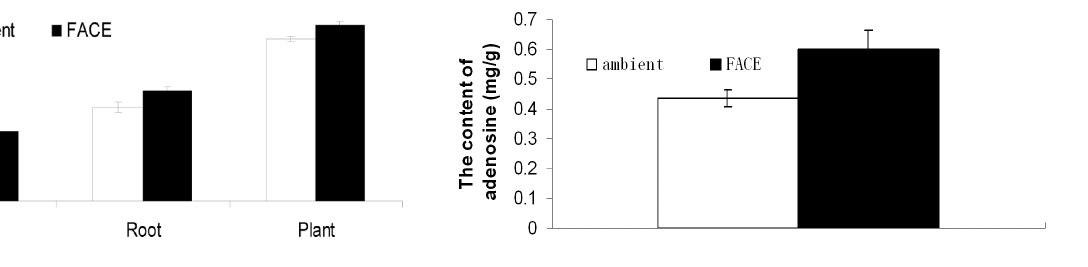
Figure 2. Effects of elevated [CO 2 ] on dry weight of leaf and root per plant. Each bar represents the standard error of the difference between treatments ( n =3). *p # 0.05.